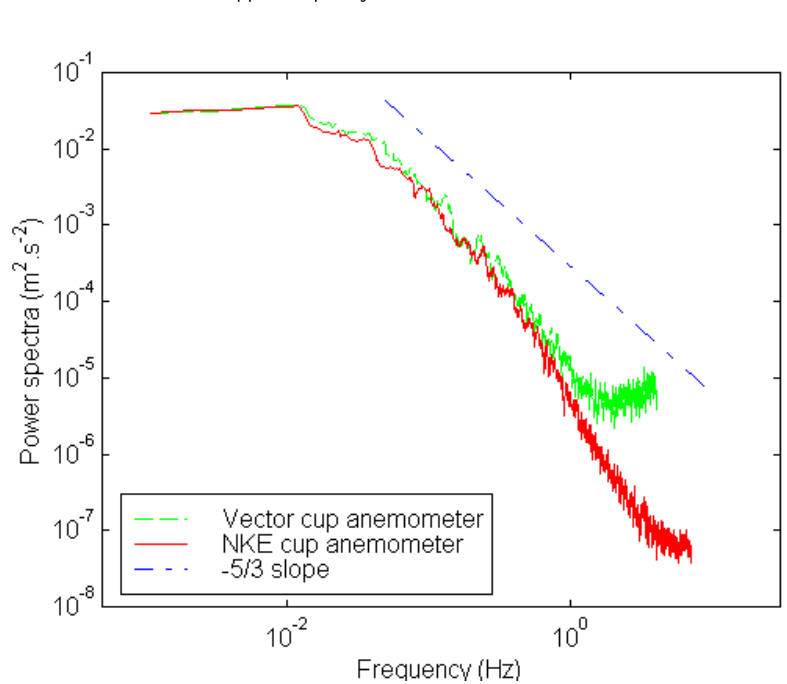
Fig. 7. Comparison between the Vector and the NKE 25-2 cup anemometers spectra (4 February 2003, sample